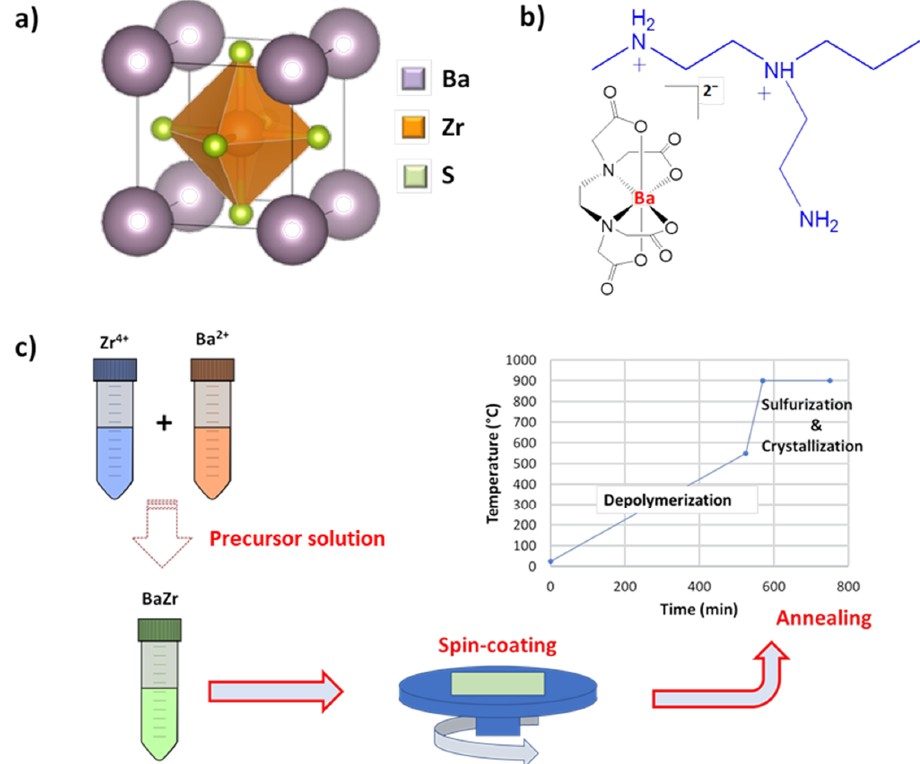
Figure 1. Schematic illustrations of ( a ) crystal structure of perovskite BaZrS 3 , ( b ) the polymer (such as PEI) in the solution binds to the metal ions (such as Ba) through electrostatic attraction, hydrogen bonding, and/or covalent bonding, and ( c ) the major stages of PAD deposition process to synthesize BaZrS 3 films.